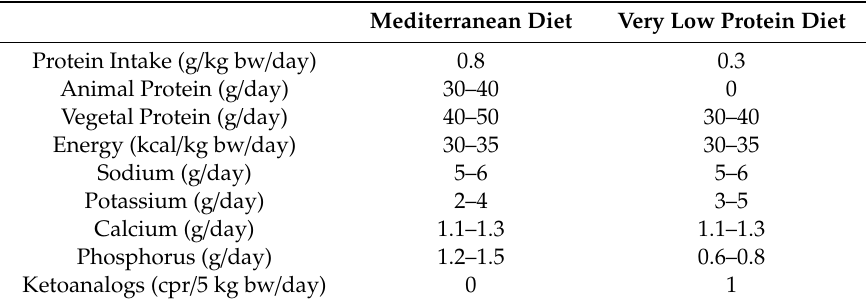
Table 1. Diet compositions.